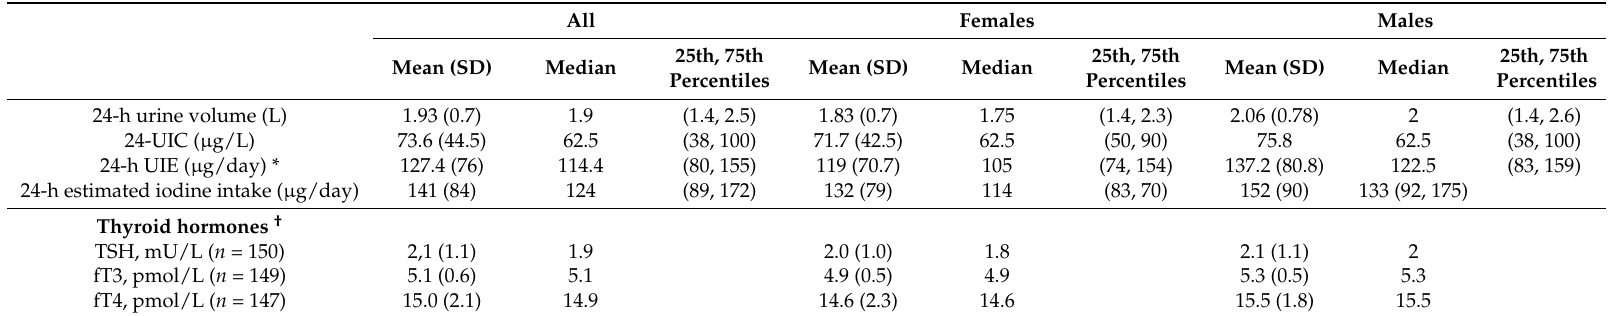
Table 2. Mean, median and interquartile ranges of 24-h urine volume, 24-h urine iodine concentration (UIC), 24-h iodine excretion (UIE) and thyroid hormones split by sex.